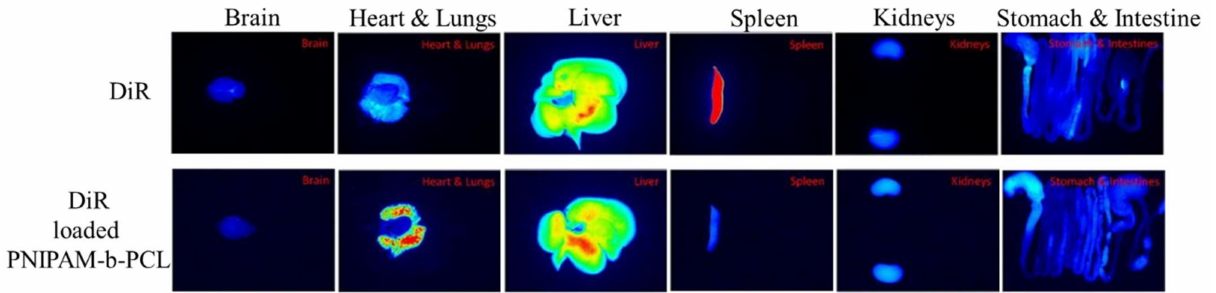
Figure 9. Fluorescence imaging of rat organs using DiR solution and DiR-loaded PNIPAM-b-PCL, reprinted from ref.